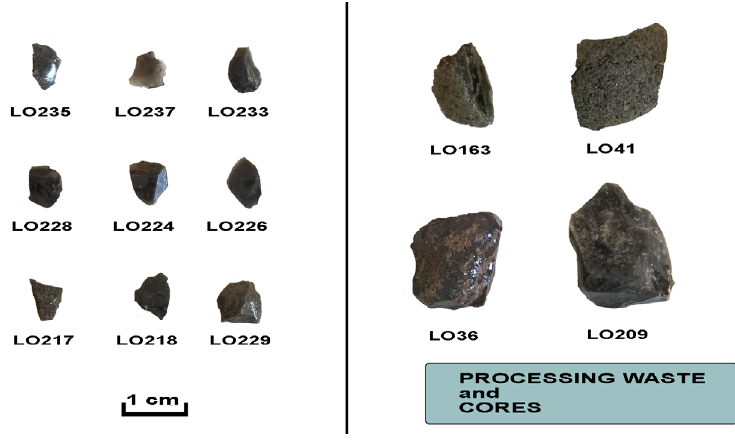
Figure 6. Some of the major typological groups of obsidian analyzed in the S–F